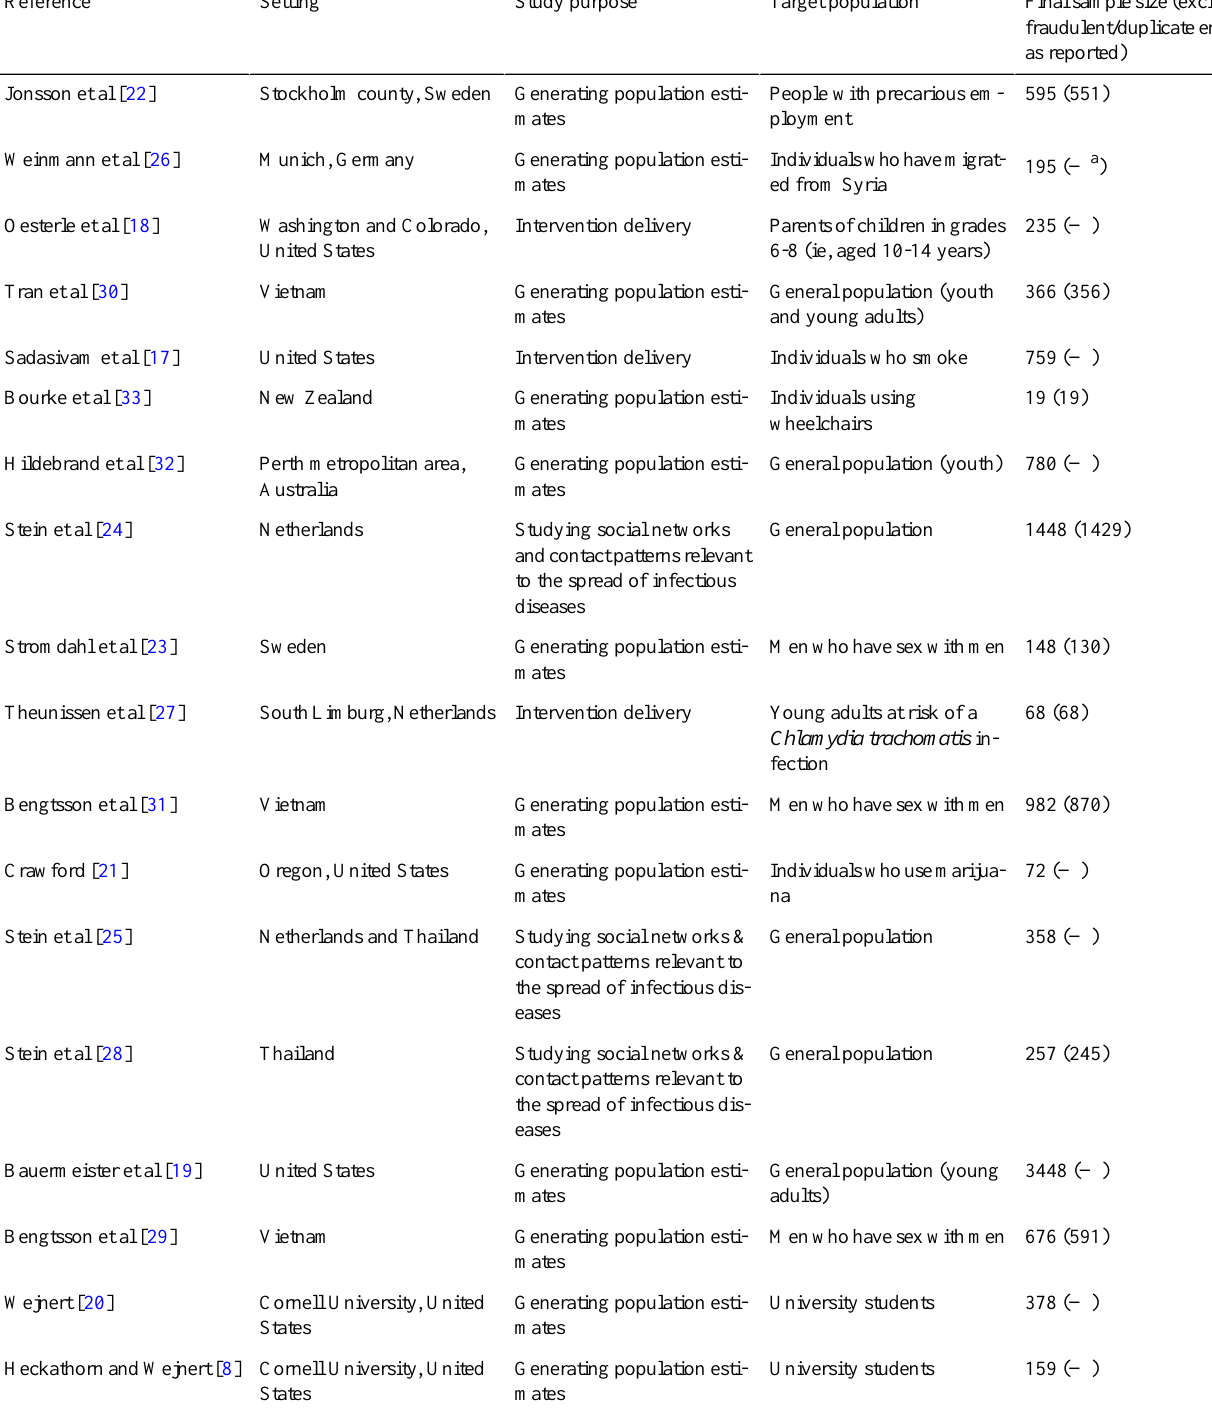
Table 3. Characteristics of the articles included in